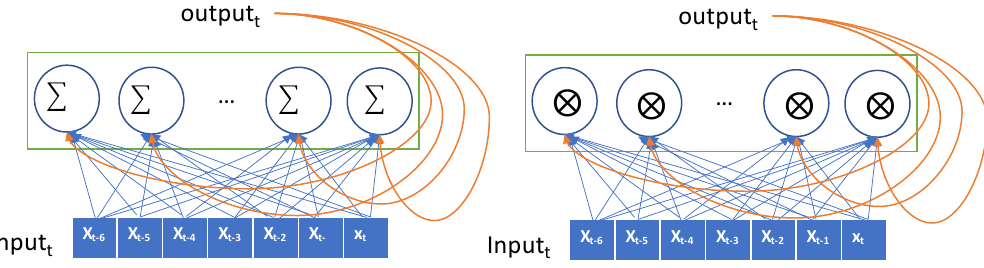
Figure 2. Conceptual description of a recurrent neural network (RNN) (Simple RNN on the left and gated recurrent unit (GRU) on the